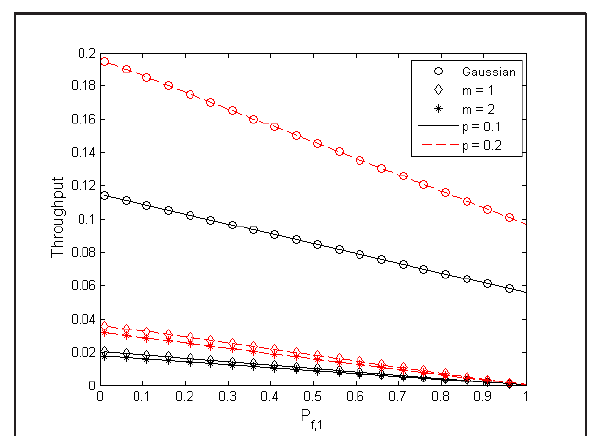
Figure 3. Per-node throughput in two coexisting CR networks with equal access. The throughput is a function of false alarm probability, the effect of Gaussian or Nakagami-m interference and transmission probability (p) on throughput of CRN